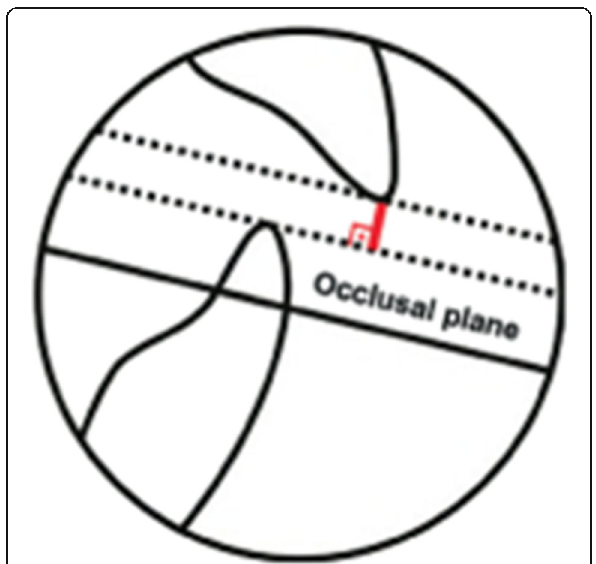
Fig. 1 Overbite measurement was defined as the distance between the maxillary and mandibular incisor borders perpendicularly to the functional occlusal